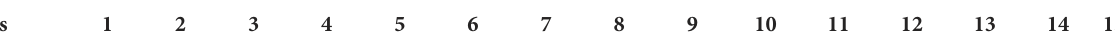
TABLE 2 Correlations among sub-types of school bullying and violent video game